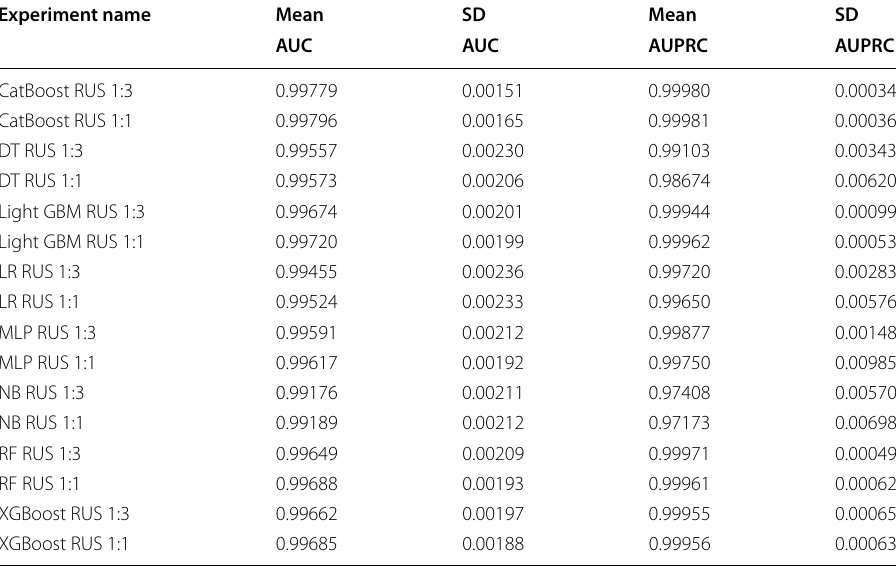
Table 33 Classification results for the keylogging dataset with sampling and default hyperparameters experiments; mean and standard deviations of AUC and AUPRC, (10 iterations of 5-fold cross-validation)